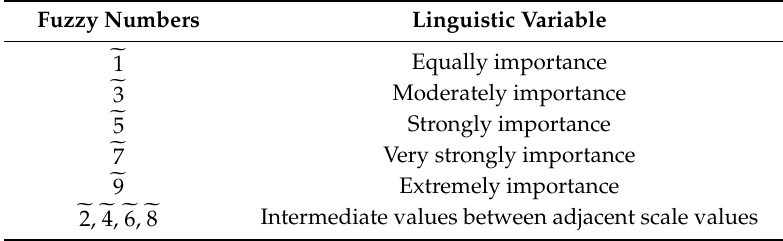
Table 1. The definition of fuzzy numbers that is divided into nine